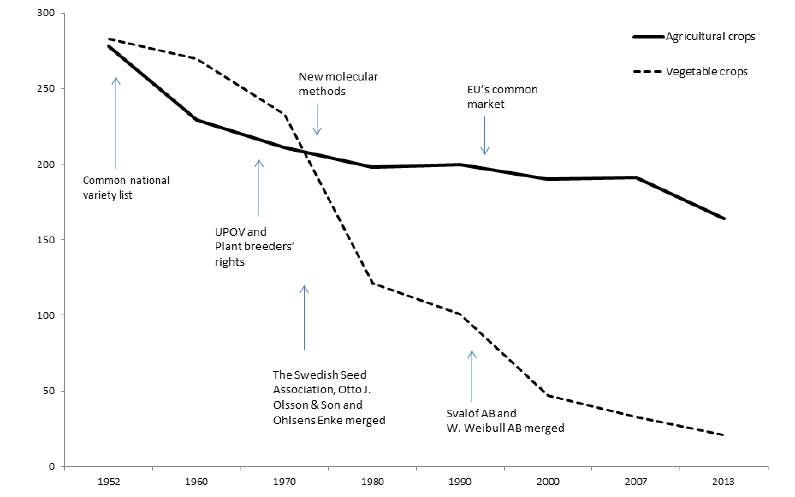
Fig. 3. Illustration of the number of nationally bred cultivars of agricultural crops and vegetables that were listed in Sweden from the 1950s onwards, and with contemporary important external and internal